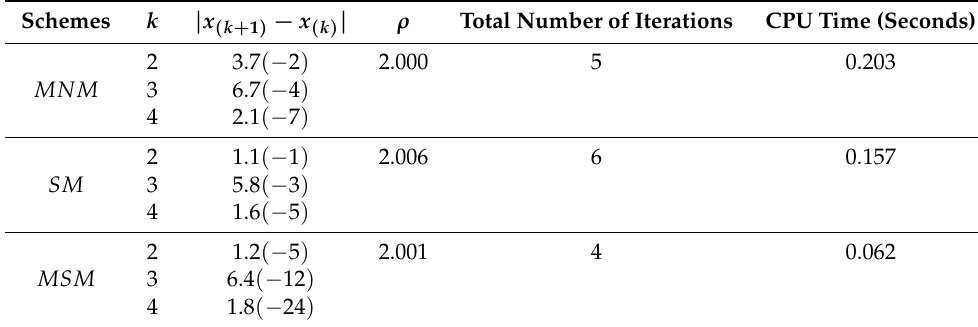
Table 1. Convergence behavior of the methods MNM , SM , and MSM at approximation x 0 = 1.